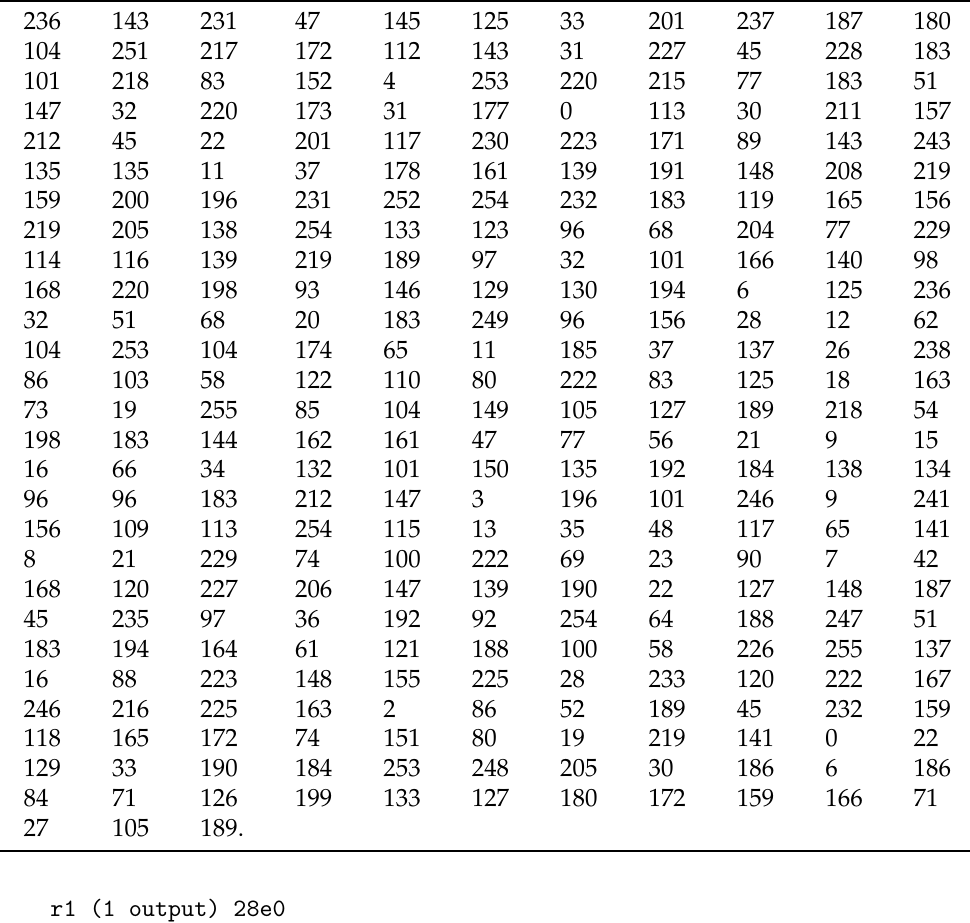
Figure 1. A netlist created from the chromosome from Table